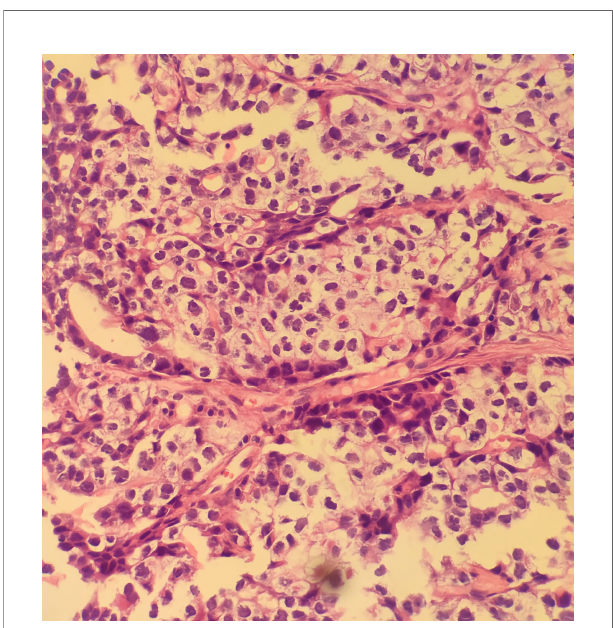
FIGURE 3 | The lesions on positron emission tomography/computed tomography (PET/CT).